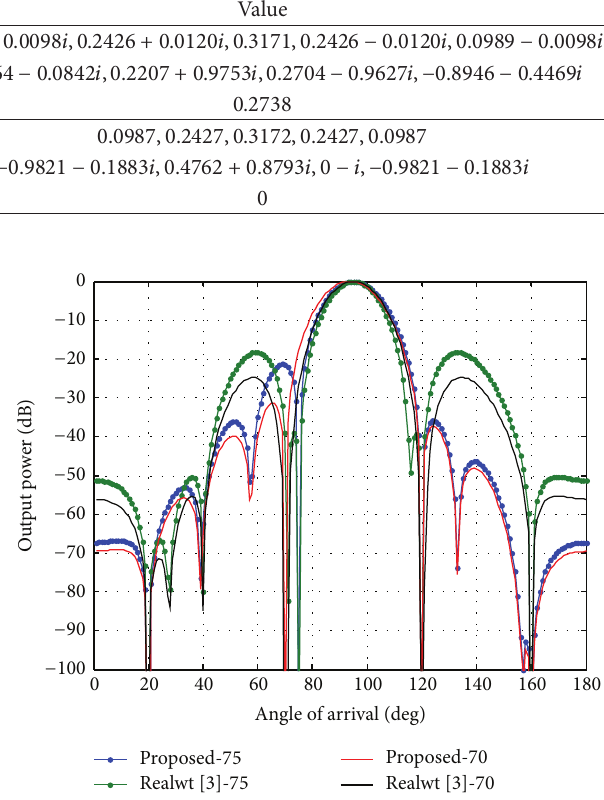
Figure 4: Performance comparison of the proposed algorithm with INS by decoupling real weights (Realwt) and INS by decoupling complex weights (Cmplxwt).